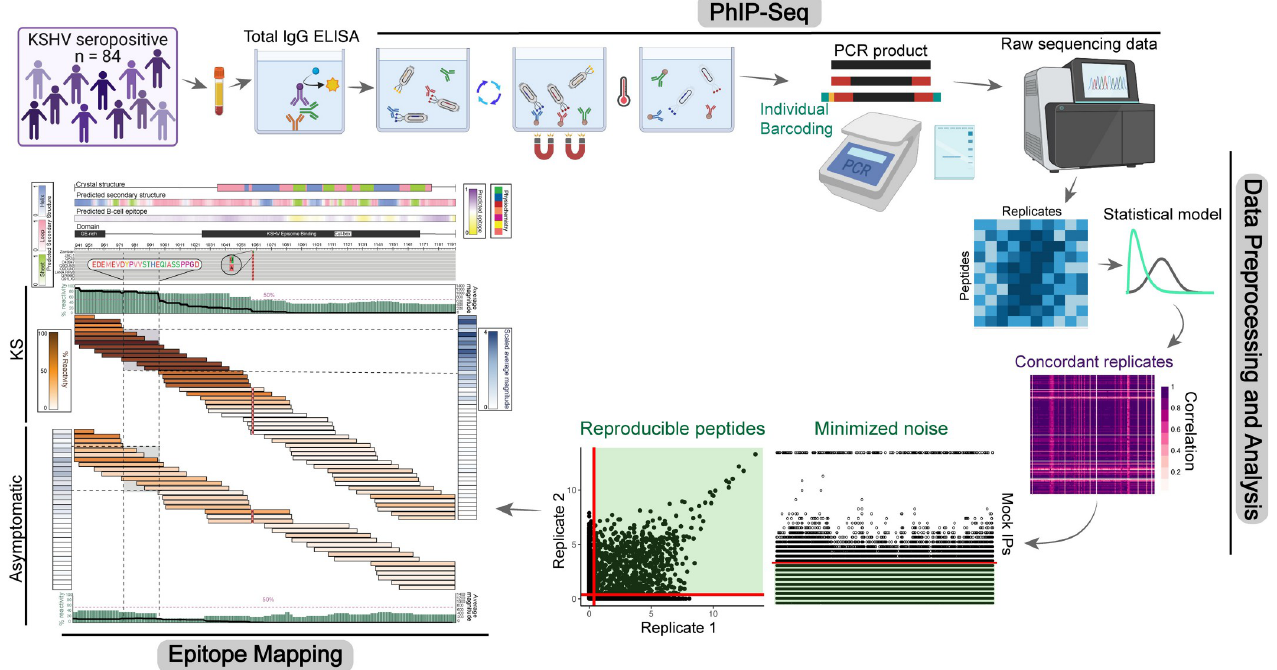
Fig 1. VirScan experiment and data analysis workflow. Phage immunoprecipitation and sequencing (PhIP-Seq) is carried out by first quantifying the levels of total IgG by ELISA, incubating the phage and plasma while rotating to allow complex formation, pulling down the phage-Ab complexes using magnetic beads and washing away the unbound phage, and finally, PCR amplification of the phage DNA followed by sequencing. The sequencing data is aligned to the reference sequences and a peptide by replicate count matrix is generated. The count data was fit to a Gamma-Poisson distribution to obtain residual p-values that represented the enrichment of a peptide above a significance-level cutoff, termed reactive peptides. Peptides were further filtered by removing peptides that had high non-specific binding in mock IPs. Samples were also filtered based on replicate correlations. Finally, statistically significant and reproducible peptides with highly concordant sample replicates were selected for downstream analyses and viral epitope mapping of KSHV-LANA. Created with BioRender.com.